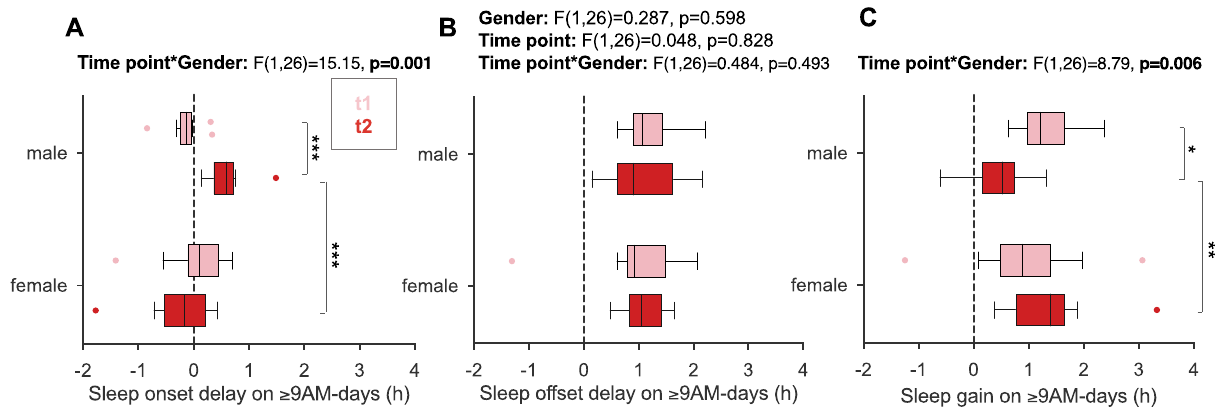
Figure 5. Gender differences in sleep onset, offset and duration on ≥ 9AM-days versus 8AM-days in the flexible system. Depicted is the absolute difference between 8AM and ≥ 9AM-days in ( A ) , average sleep onset (sleep onset delay) and ( B ) , average sleep offset (sleep offset delay) and ( C ) , average sleep duration (sleep gain) per individual from the longitudinal cohort (n = 28), with positive numbers indicating higher values on ≥ 9AM-days. Results of two-way mixed ANOVAs with the between-subjects factor gender (female/male) and the within-subjects factor time point (light red = t1/red = t2) are reported above each graph. Given the significant interaction effect on sleep onset delay, main effects are not reported, instead statistically significant post-hoc comparisons are indicated. See main text and Supplementary Tab. S1 for detailed effect sizes. All boxplots